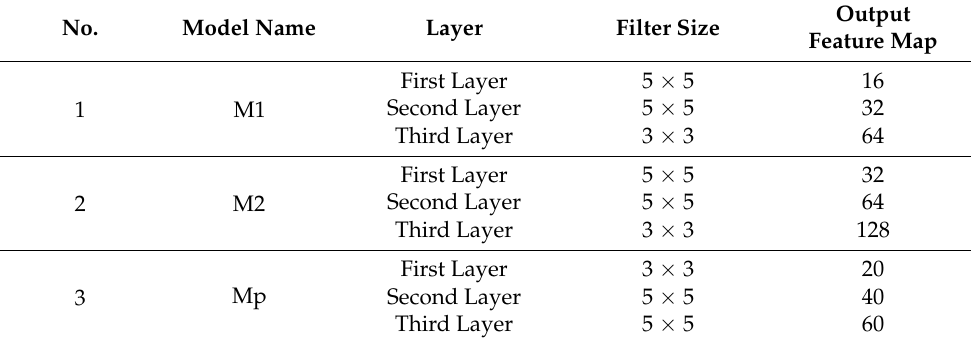
Table 3. Description of model architectures.